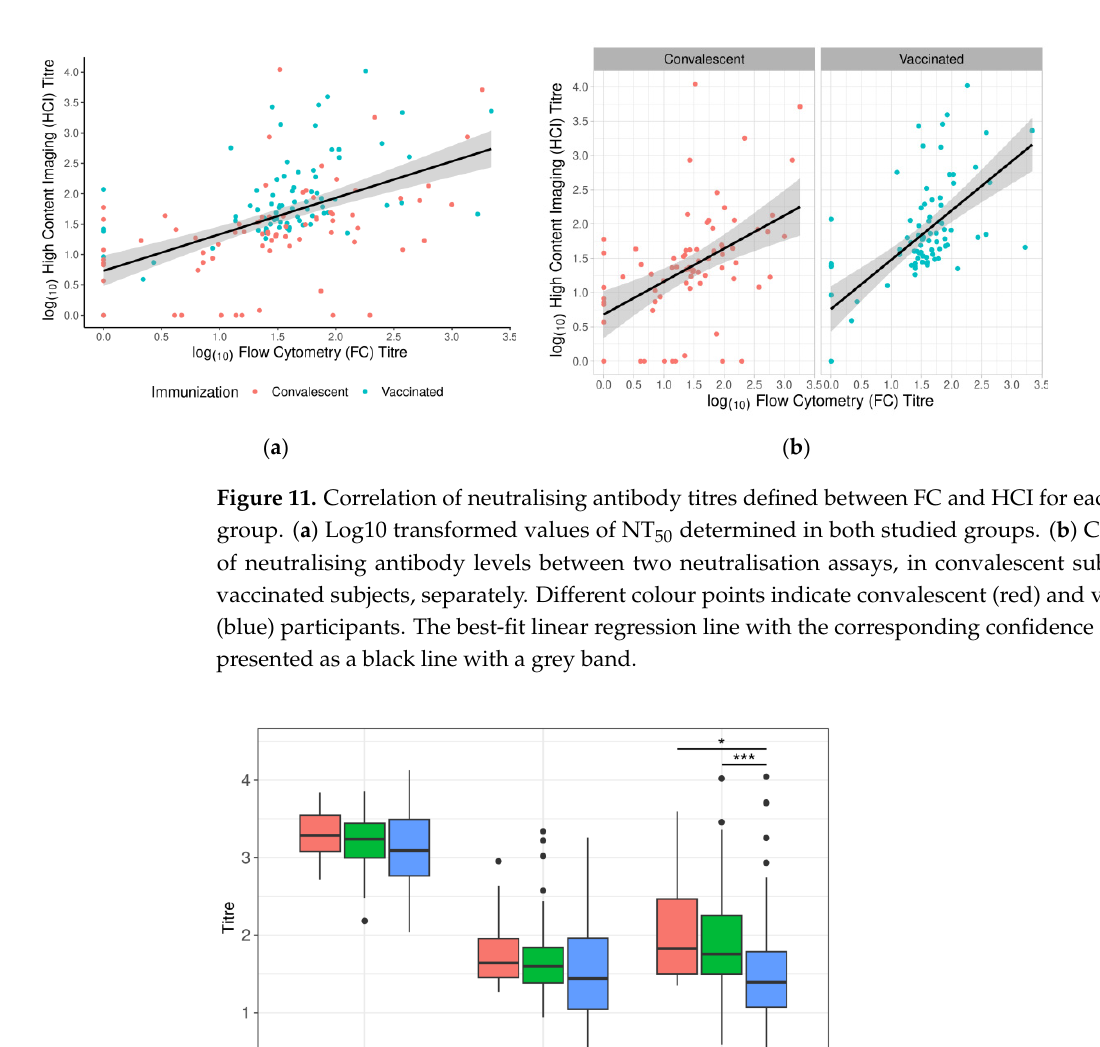
( b ) Figure 10. Anti-RBD IgG antibodies in human sera and their correlation with neutralising titre. ( a ) Log10 transformed values of titres obtained from ELISA RBD and NT 50 determined by HCI. ( b ) Correlation between anti-RBD IgG and neutralising antibody levels in convalescent subjects and vaccinated subjects. Di ff erent colour points indicate convalescent (red) and vaccinated (blue) partic- ipants. The best- fi t linear regression line with the corresponding con fi dence interval is presented as a black line with a grey band. We divided the subjects into convalescent and vaccinated groups to de fi ne whether neutralising titres obtained by HCI and antispike RBD IgG levels were correlated. The correlation coe ffi cient was ρ = 0.52 when comparing the overall titres in both studied groups (Figure 10a), but we noticed a higher correlation in the vaccinated group ( ρ = 0.53) compared to the convalescent group ( ρ = 0.45) (Figure 10b). In this study, we also compared samples from convalescent patients and vaccinated individuals. Both groups of samples were tested with all three tests (Table 1). The results showed a statistically signi fi cant di ff erence between the groups only in the HCI assay ( p < 0.001). The median titre of the vaccinated individuals was 60.9 (range: 1–10,451) and was signi fi cantly higher than that in the convalescent patients, where the median titre was 24.6 (range: 1–11,051), p < 0.001. The result of our study is consistent with previous publica-